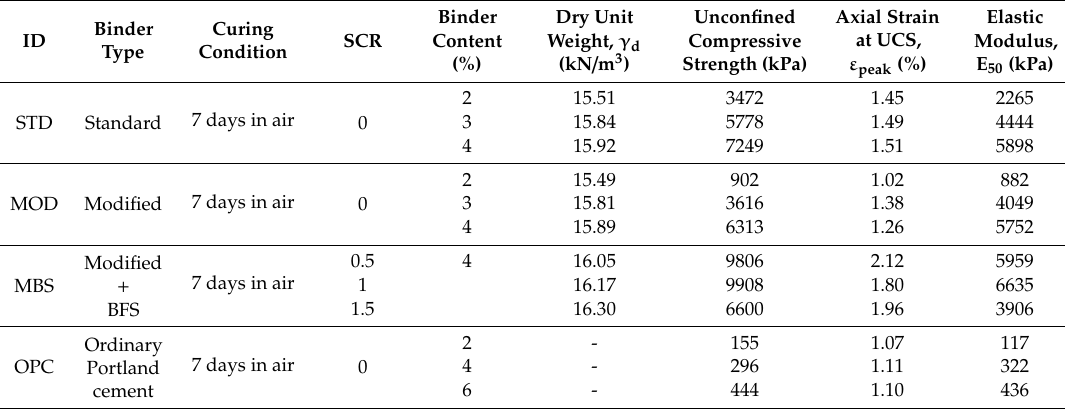
Figure 8. Stress-Strain relationship of casein and / or slag cemented ( a ) STD, ( b ) MOD, and ( c ) MBS samples. Table 7. Summary of the unconfined compression test results after 7 days of curing in